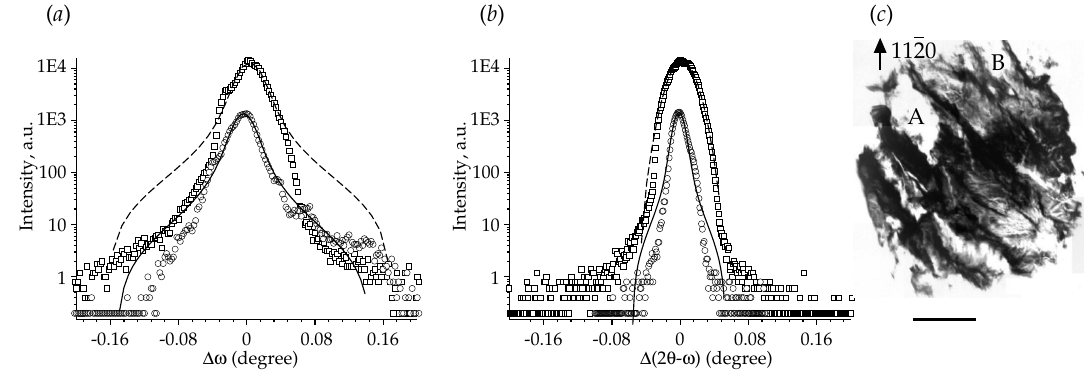
Figure 5. Superimposed ω and 2 θ − ω scans for type II layer of AlN. ( a ) ω –scans from 0004 (squares) and 1014 (circles) reflections. Log scale. The peaks have fitted widths of 114 and 101 arcsec, respectively. Voight fit is shown by dashed and solid lines; ( b ) (2 θ − ω ) scans from 0004 and 1014 reflections. The peaks have fitted widths of 110 and 51 arcsec, respectively; ( c ) X-ray diffraction topograph of type II layer taken with 1120 reflection using monochromatic radiation with principal photon energy E = 15 keV. Scale bar 2 mm. Photonic Science